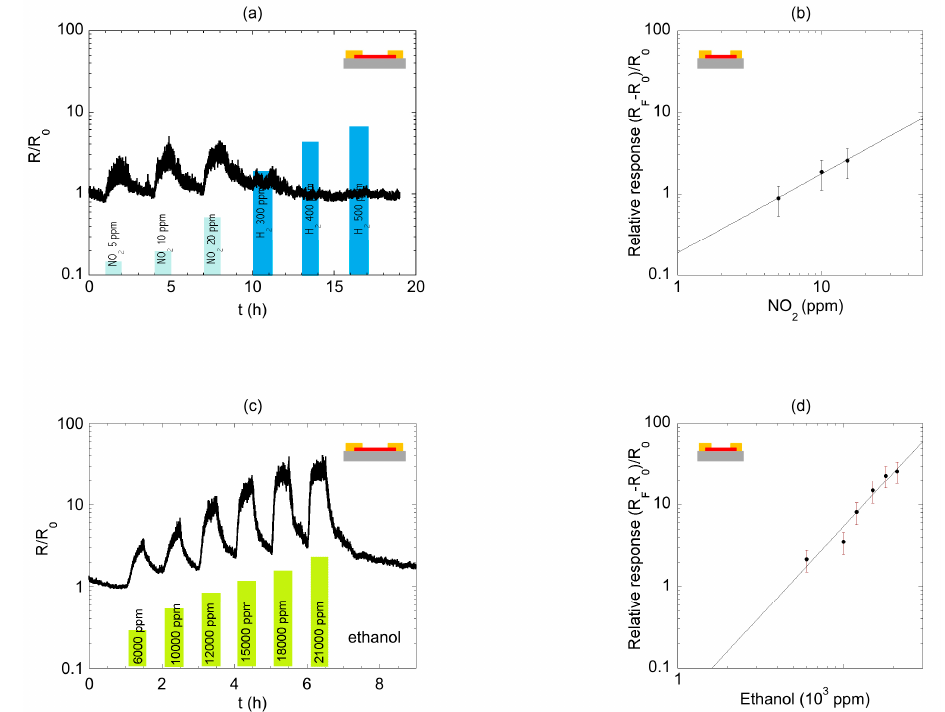
Figure 5. ( a ) Dynamic variation of the normalized resistance for supported nanowire (NW) towards NO 2 (5–10–20 ppm in dry air) and H 2 (300–400–500 ppm in dry air). ( b ) Calibration plot for NO 2 detection; parameters of the power law in the fit are A = 0.19; B = 0.96. ( c ) Dynamic variation of the normalized resistance for supported NW towards ethanol (in the range 20% to 70%, corresponding to the range 6000 ppm–21000 ppm). ( d ) Calibration plot for ethanol detection; parameters of the power law in the fit are A = 0.002; B = 2.16.